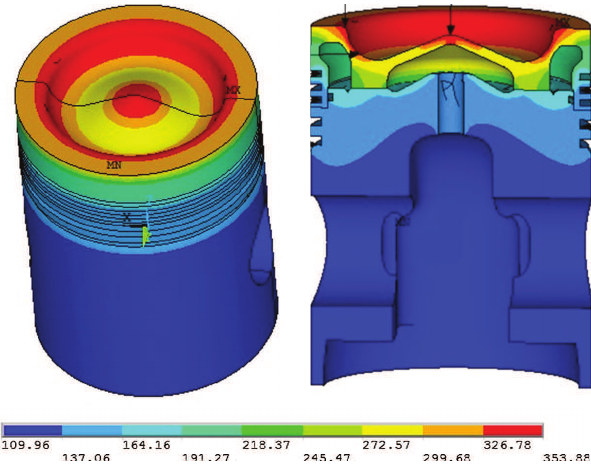
Fig. 9. Distribution of temperatures on the piston surface and inside the piston [23]